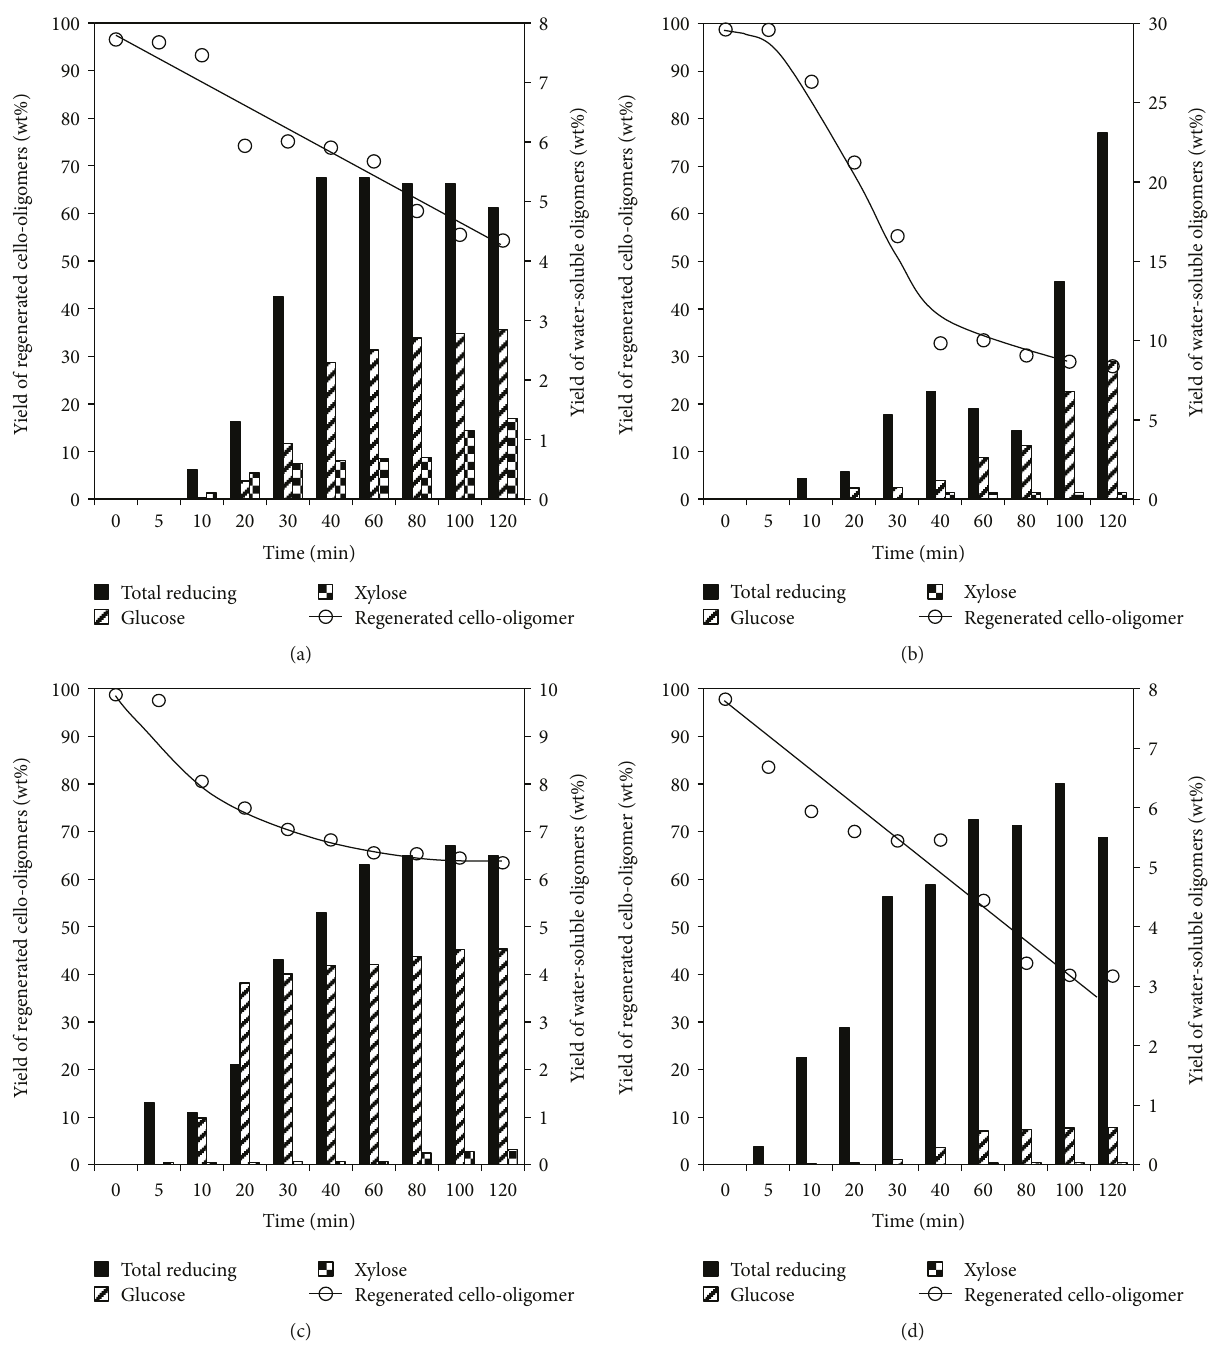
Figure 4: Yields of cello-oligomers and water-soluble sugar products derived from depolymerization of cellulose fi bres of (a) sawdust, (b) sugarcane bagasse, (c) corn cob, and (d) sago pith wastes at di ff erent reaction times (acid catalyst concentration = 0 23mmol H O + ; temperature = 80 ° C 3